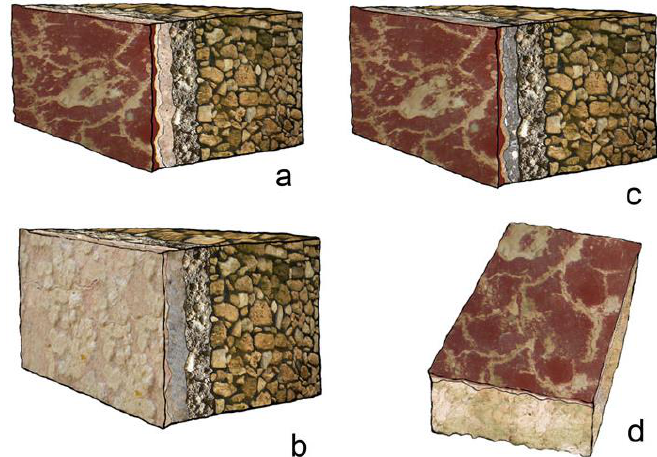
Figure 6. Types of plaster based on the manufacturing technique. ( a ) type 1; ( b ) type 2; ( c ) type 3; ( d ) type 4.